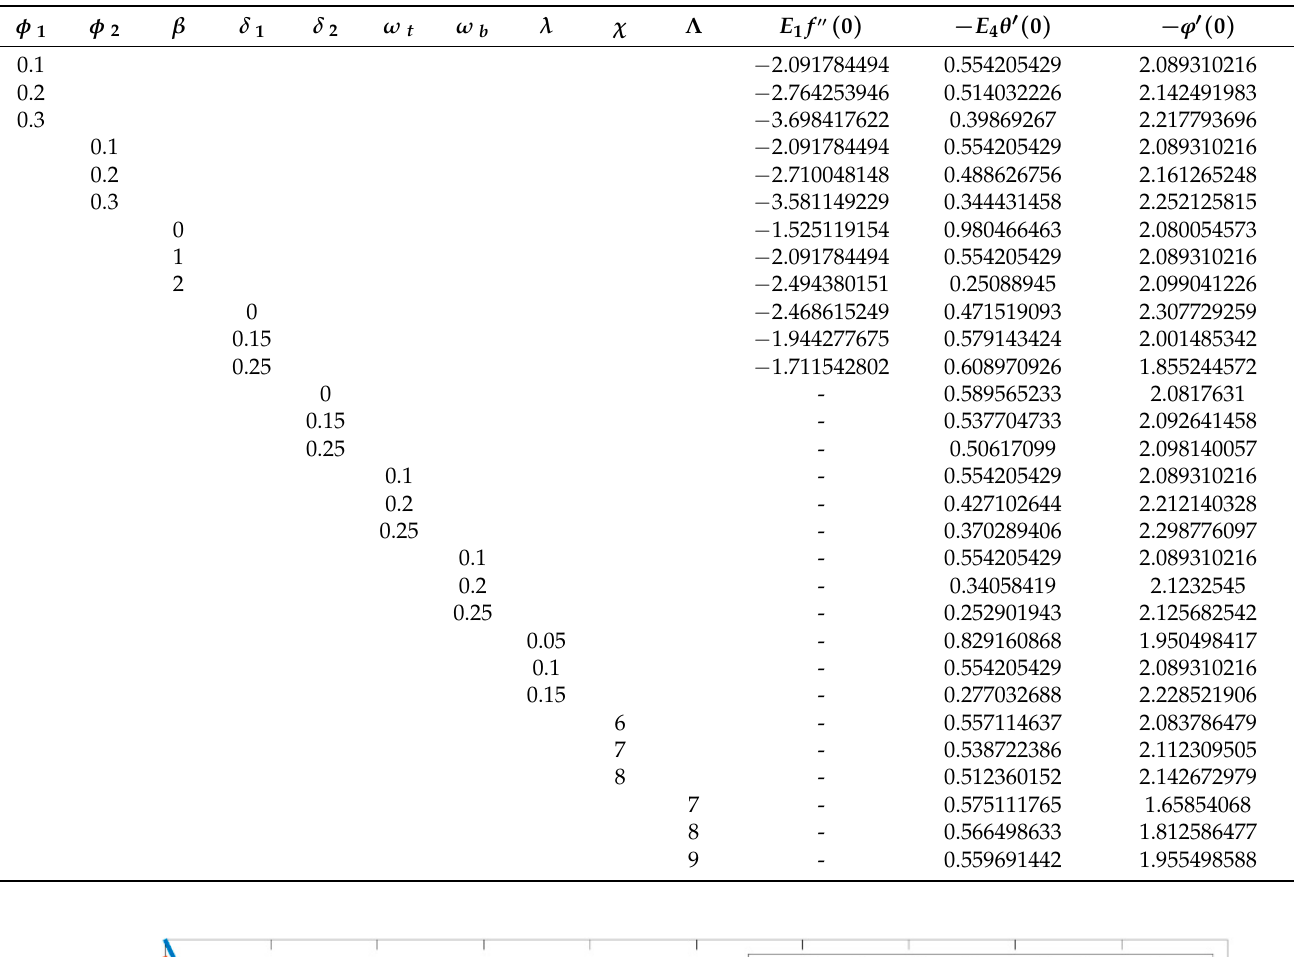
Table 4. Computational results of Equation (50) using the Keller–Box method.